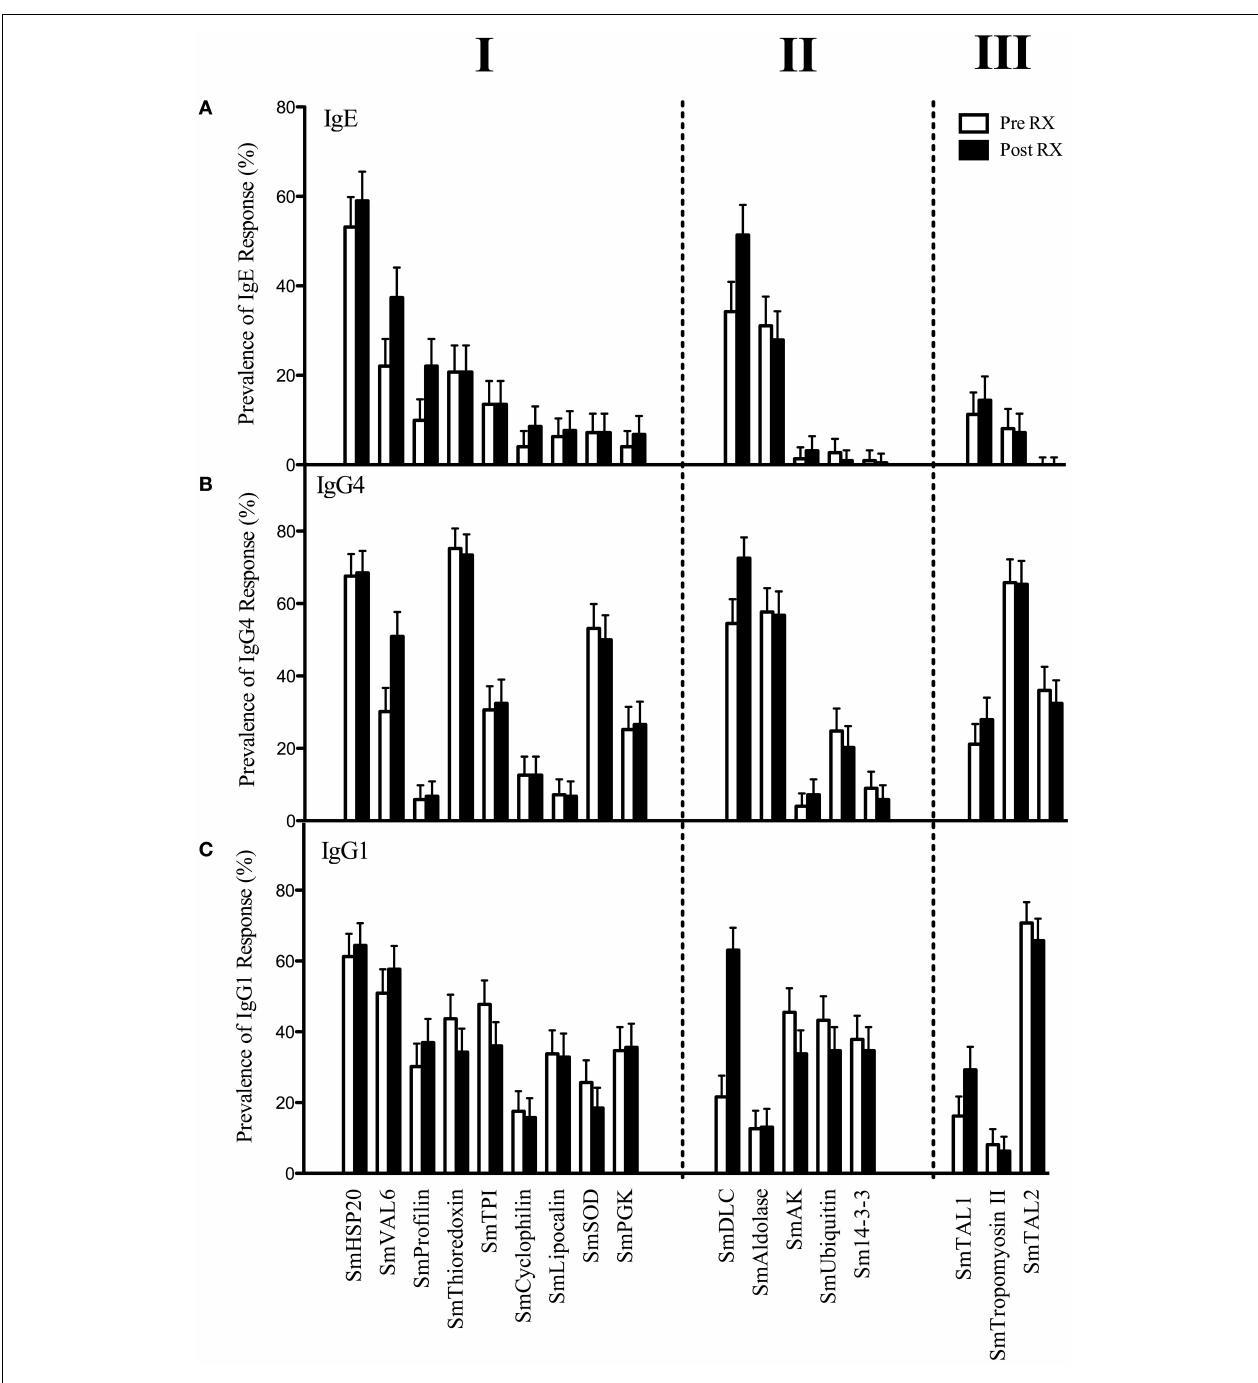
sensitivity cut-offs (mean + 3 σ ) determined using sera from 26 normal European controls. Proteins were grouped into predicted IgE-binding antigens (I), antigens without known allergenic domains (II), and confirmed IgE-binding antigens